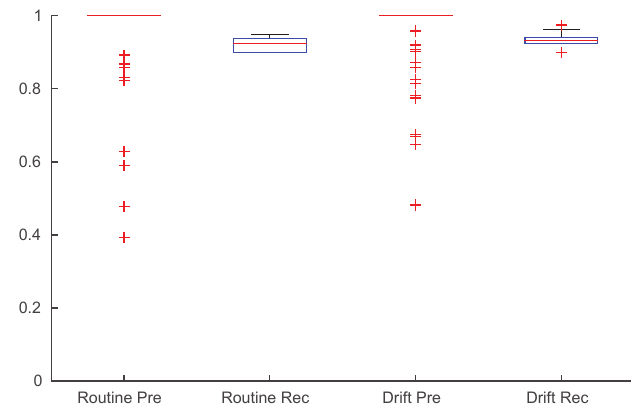
Figure 3. Results of Watching TV detection in both datasets, Precision and Recall represented in a box plot. Red line depicts the expected value, the blue box contains data from the 25th to 75th percentiles, the whiskers mark the most extreme datapoints, and the outliers are marked individually.